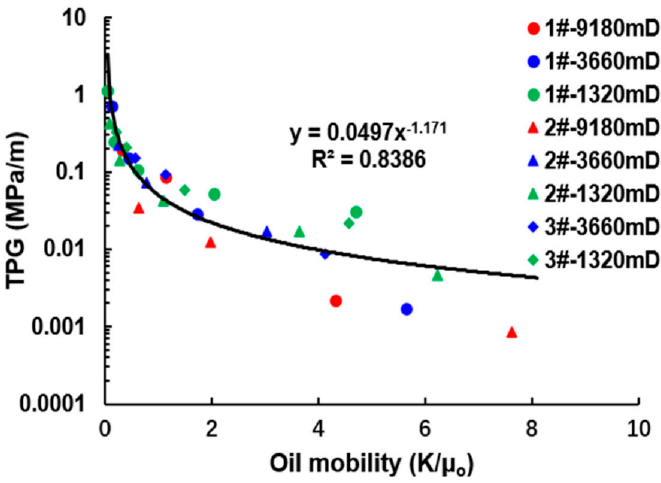
Figure 4. The relationship between the TPG and oil mobility